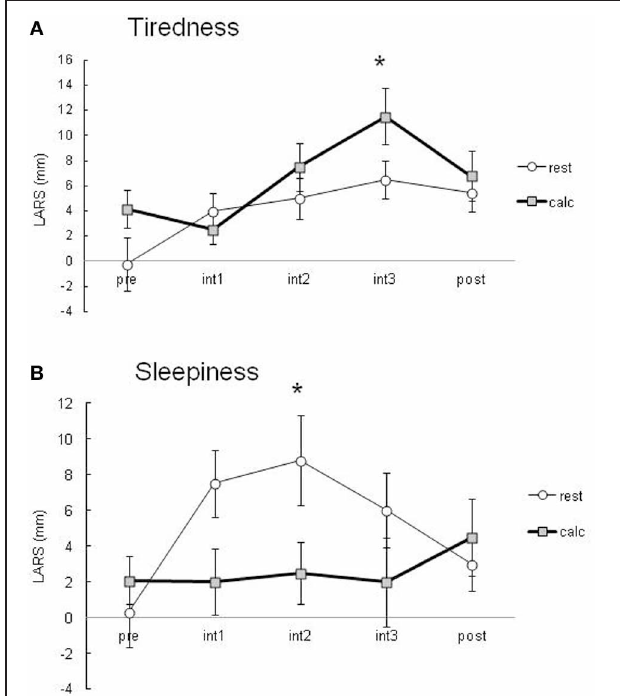
FIGURE 2 | Subjective tiredness (A) and sleepiness (B) evaluated using LARS during PET scans. Data are presented as the means ± SEM of LARS (mm) from 10 healthy subjects in the resting and calculation conditions. All data were analyzed by a repeated measure of ANOVA followed by multiple comparisons and P < 0 . 05 was considered statistically